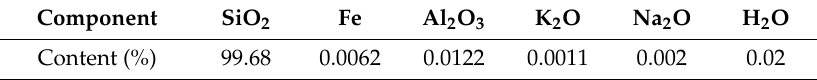
Table 3. Chemical compositions of quartz sand.